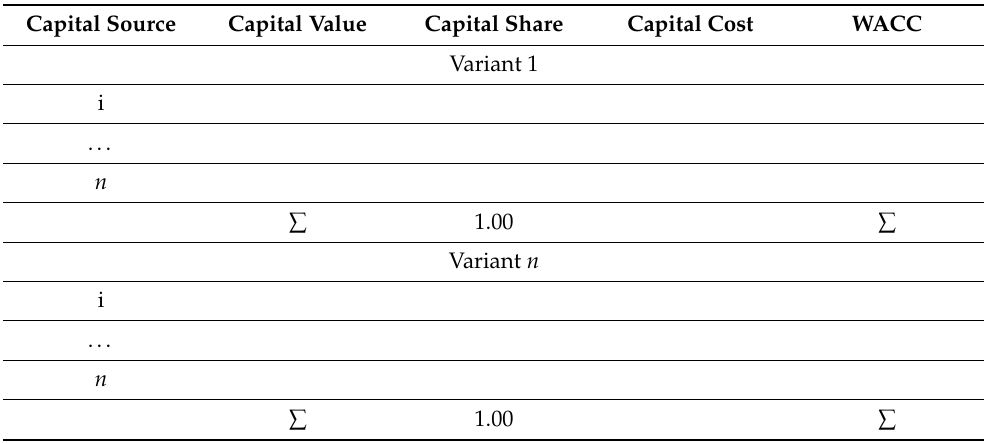
Table 9. Sources of capital, their value, structure, and cost, as well as the weighted average cost of capital in possible variants of project financing. Source: designed by